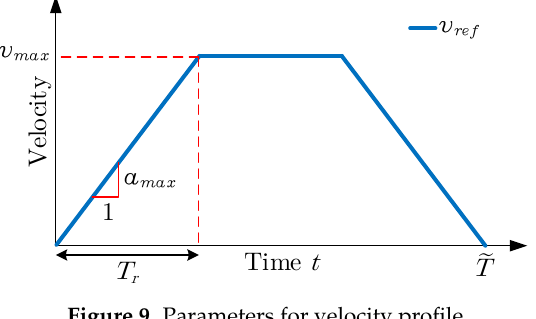
Figure 9. Parameters for velocity